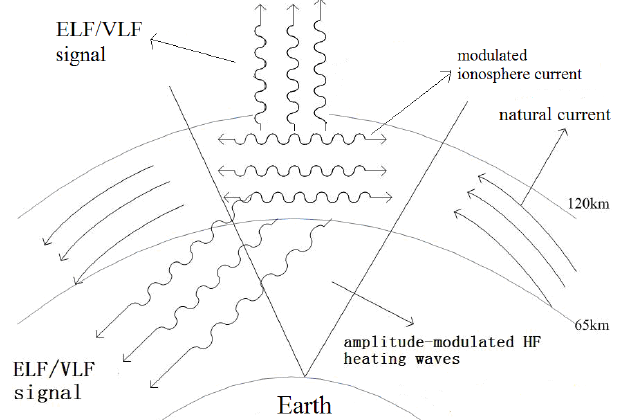
Figure 1. Schematic showing the generation of ELF/VLF whistler waves by modulated HF heating of the ionosphere and their subse- quent propagation.